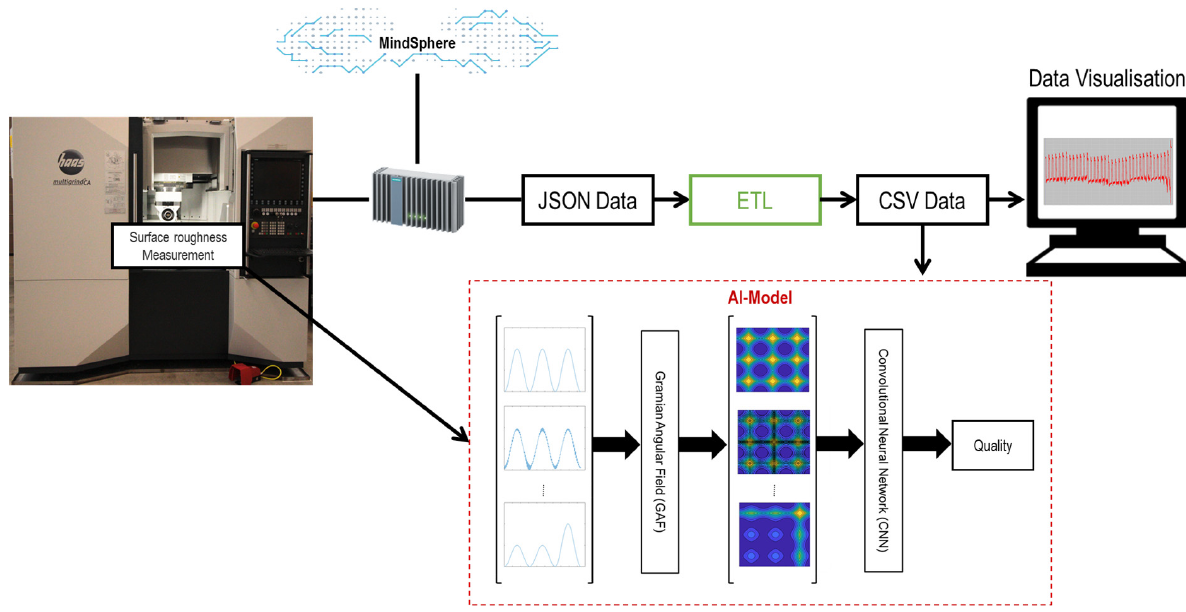
Figure 1. Schematic representation of the integration of the ETL program and AI Model.